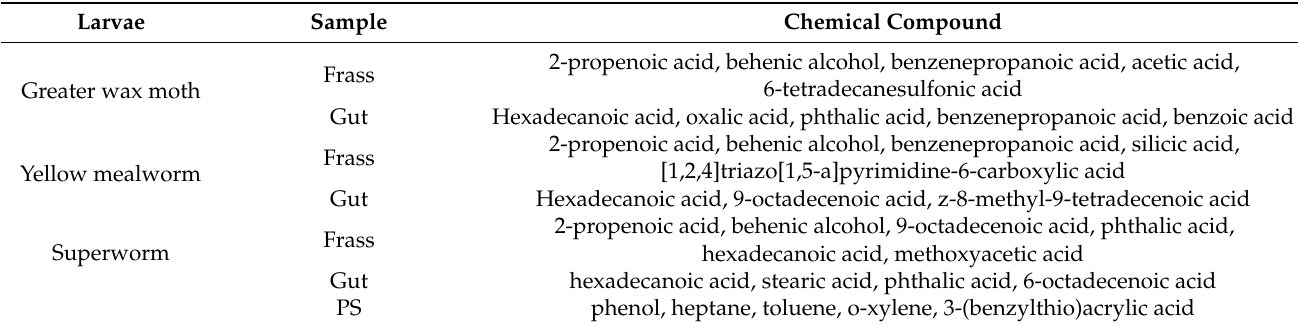
Table 3. Chemical compounds of PS and the frass, and gut of larvae analyzed by